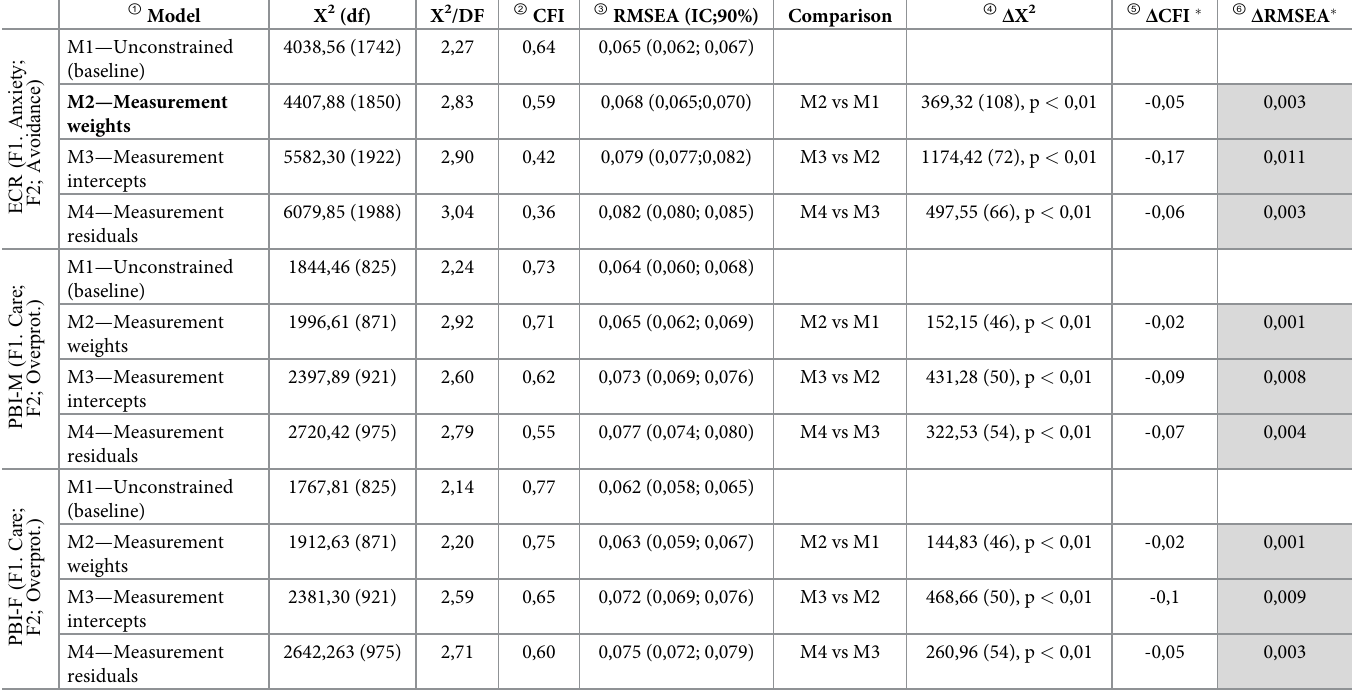
Table 4. Multigroup confirmatory factorial analysis